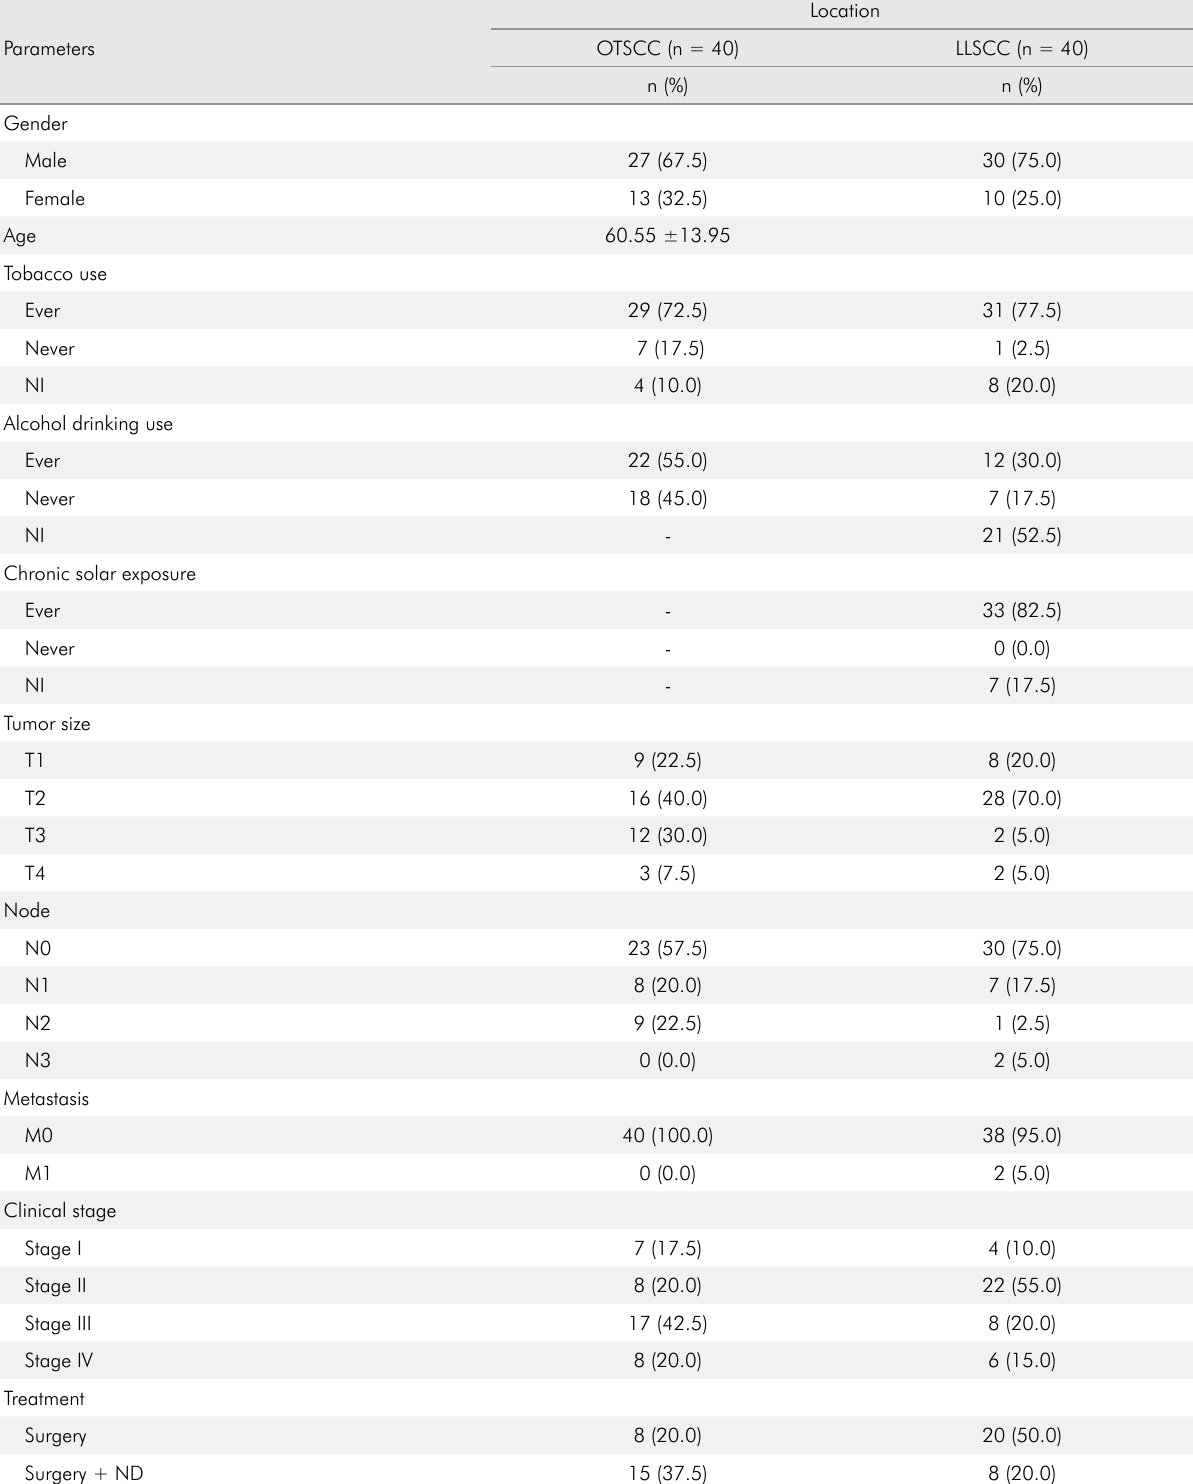
Table 1. Descriptive analysis of socio-demographic and clinical variables of the oral tongue squamous cell carcinoma (OTSCC) and lower lip squamous cell carcinoma (LLSCC)